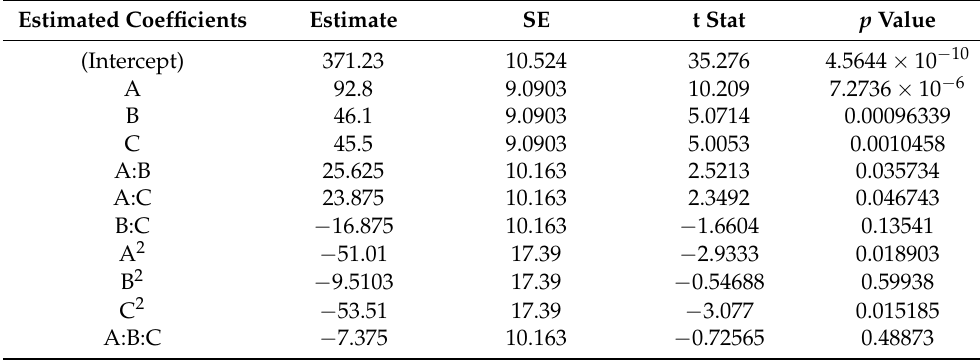
Table A2. Regression table for linear regression model. Estimated Coefficients